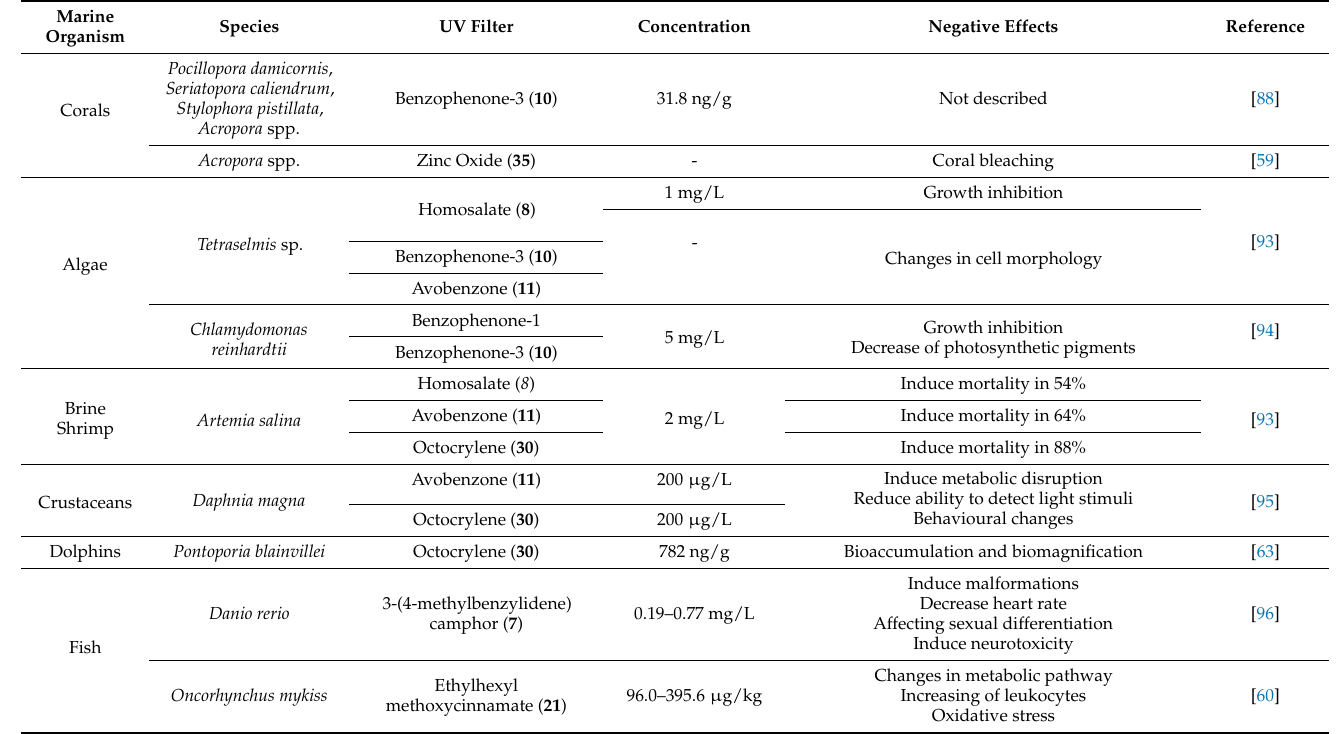
Table 2. Summary of the negative impact of UV Filters in marine